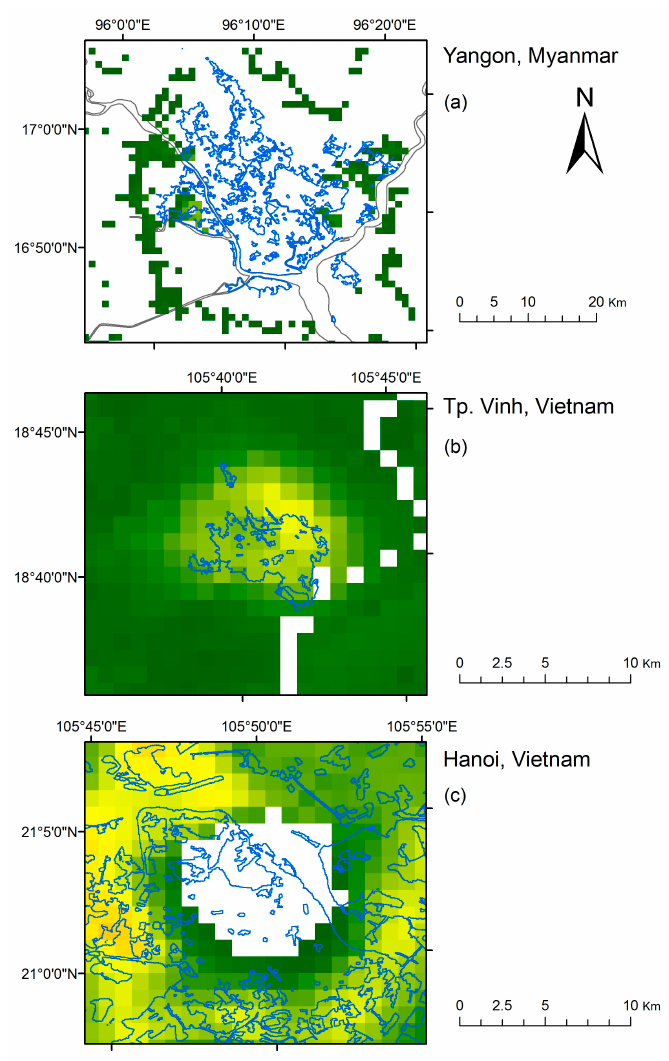
Figure 8. Overlay of the 2010, 30 m urban built-up map (blue polygons) on top of DMSP/OLS NTL trends (grids in a green-red gradient color indicates a small to large increase in NTL brightness), where ( a ) an old city with stable urban built-up, ( b ) a completely new city with newly-developed urban built-up and ( c ) a growing city that was fast growing in built-up areas are shown.